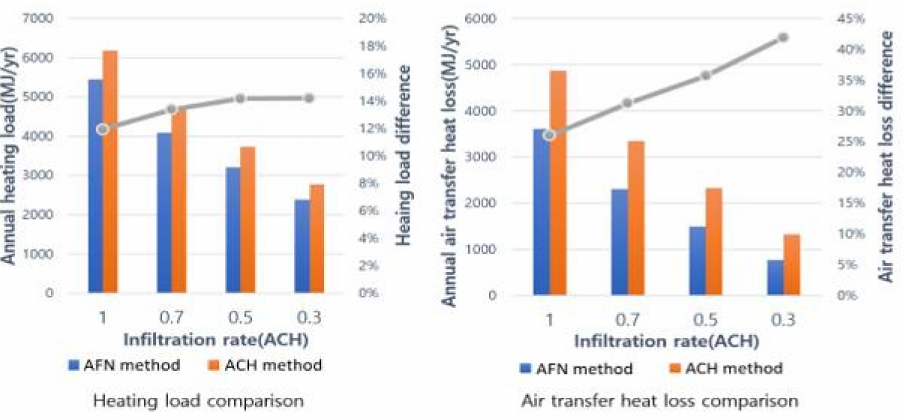
Figure 10. Comparison of the AFN model and ACH model when used to describe annual heating load and air transfer heat loss in parametric analysis